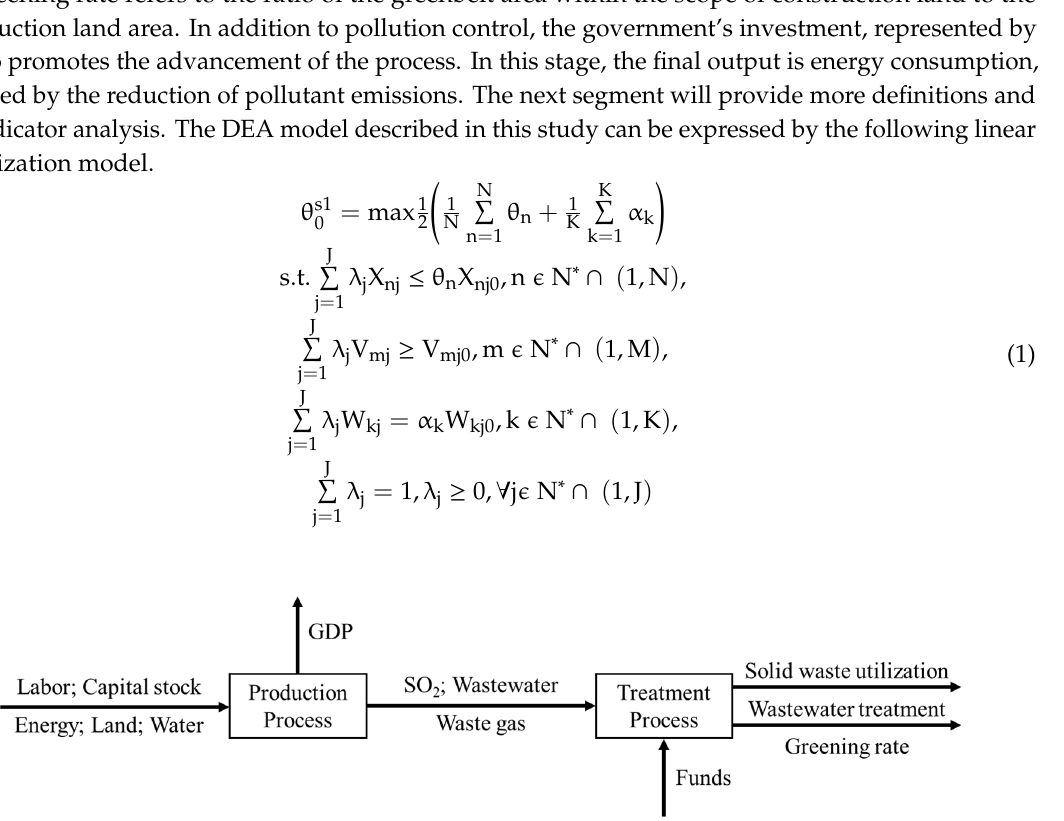
Figure 1. Conceptual framework of two stages of eco-efficiency. (Source: Authors compiled).